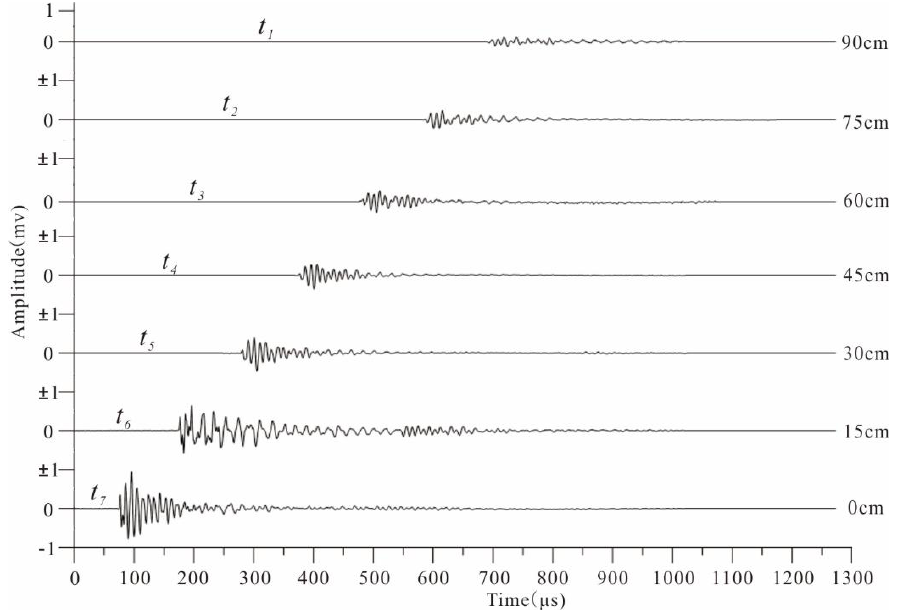
Figure 3. The waveforms received by transducer R2 from one columnar